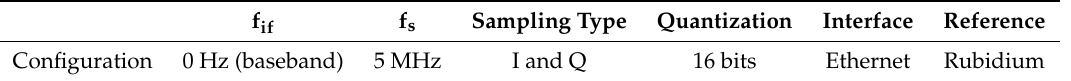
Table 2. USRP N210 configuration